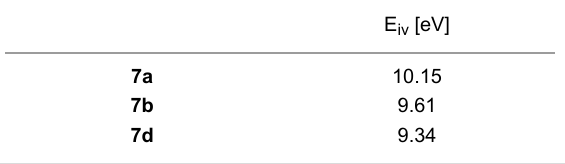
Table 3: Vertical ionization energies (E iv ) of isoxazoles 7a , 7b and 7d .